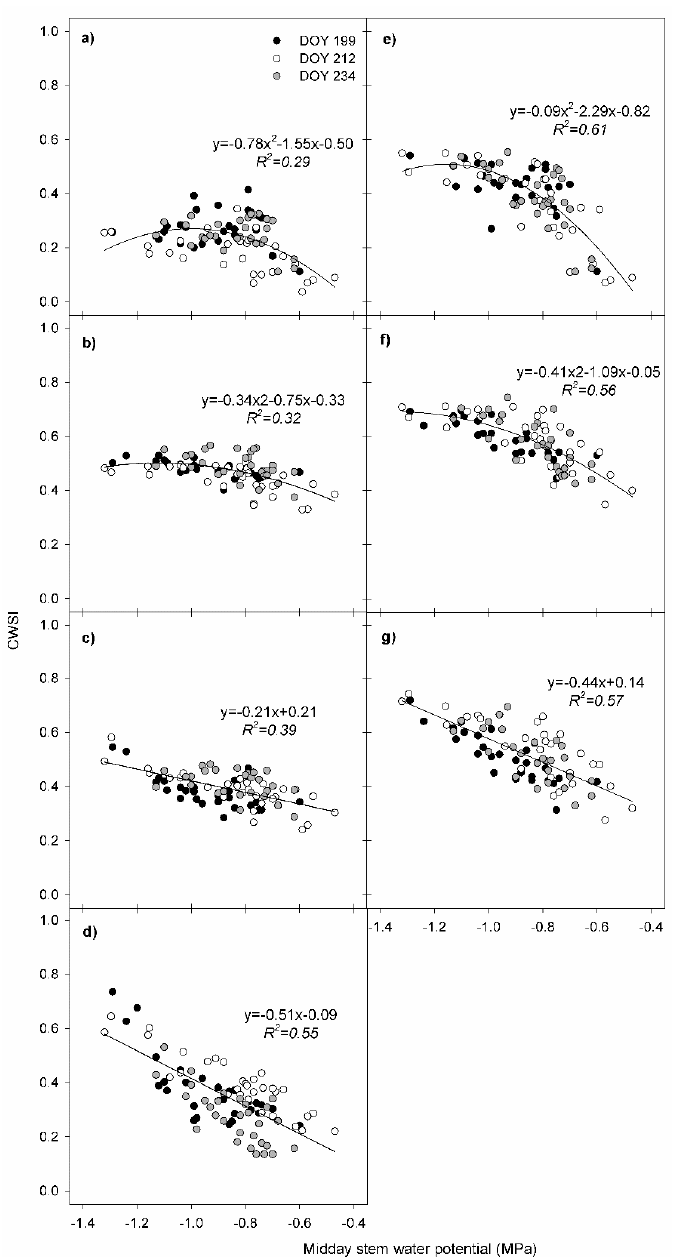
Figure 6. Scatterplots of the regression between stem water potential and the crop water stress index (CWSI), calculated as 1-T / T 0 for three dates: 18 July (DOY 199), 31 July (DOY 212) and 22 August (DOY 234). T 0 was obtained using the Shuttleworth and Wallace method and T was obtained from ( a ) TSEB-PT S2 + 3 , ( b ) TSEB-PT airb , ( c ) TSEB-2T and ( d ) the baseline empirical approach of Bellvert et al. (2016). ( e – g ) show a relative CWSI (CWSI rel ) using the highest T 0 of the vineyard. Validation was conducted with pixels containing the 32 measured vines.